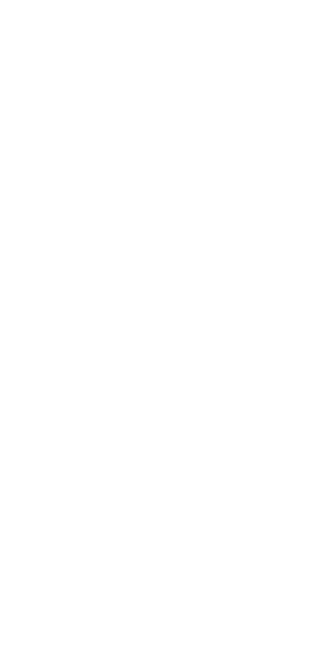
Fig 5. Transfer entropy at scanning. Transfer entropy as a function of Period (Exposition, Memory M1, Memory M2) for 0 – 90° patterns (white boxes) and 105 – 180° patterns (black boxes).